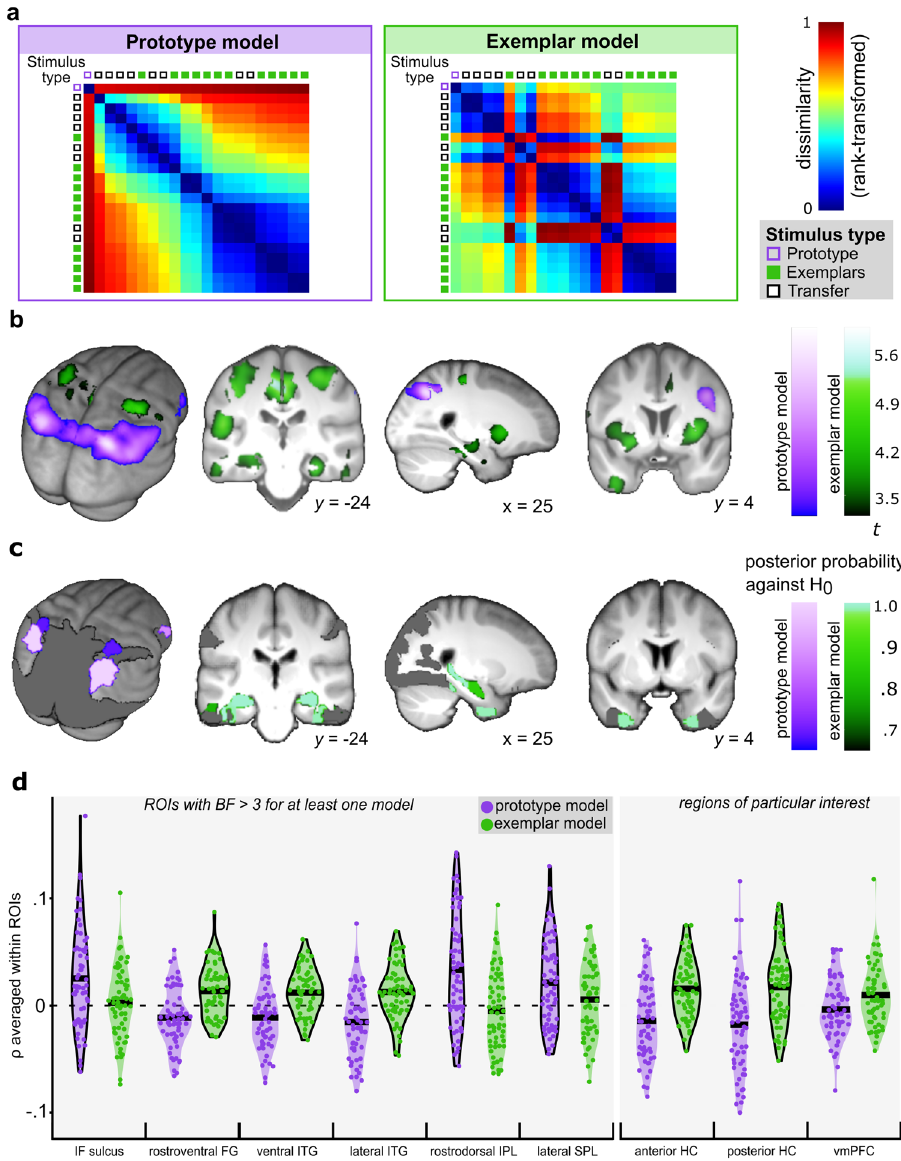
Fig. 3 Multivariate analyses on the group level ( n = 62 individuals). a Examples of representational dissimilarity matrices (RDM) for the prototype and the exemplar model from one volunteer. Each cell in the model RDM represents absolute differences between similarity estimates of a category member stimulus pair. For visualisation purposes, both model RDMs were sorted by similarity to the prototype in descending order and were rank-transformed. The small squares represent single stimuli. The prototype, which is also a category A transfer item, is denoted by a purple framed square. All other transfer items are denoted by black framed squares. The exemplars are denoted by green- fi lled squares. b Multivariate prototype and exemplar representations. Multivariate representational similarity analyses (RSA) show signi fi cant fi ts of the prototype (purple) and the exemplar (green) models. Statistical t -maps are thresholded at p unc < 0.001 for visualisation purposes. c ROI-speci fi c posterior probabilities that multivariate effect sizes (ES RSA ) for prototype (purple) and exemplar (green) representations deviate from zero. Only ROIs with a BF > 3 for the comparison against the null model are depicted. d Violin plots of observed ES RSA for ROIs with a BF >3 for the comparison against the null and ROIs of particular interest. The bolded horizontal lines depict the mean ES within each ROI. Black borders around the violin plots highlight effects with a BF > 3. Black borders around the violin plots highlight effects with a BF > prototype- and exemplar-based categorisation, prototype and exemplar representations were localised in different regions.